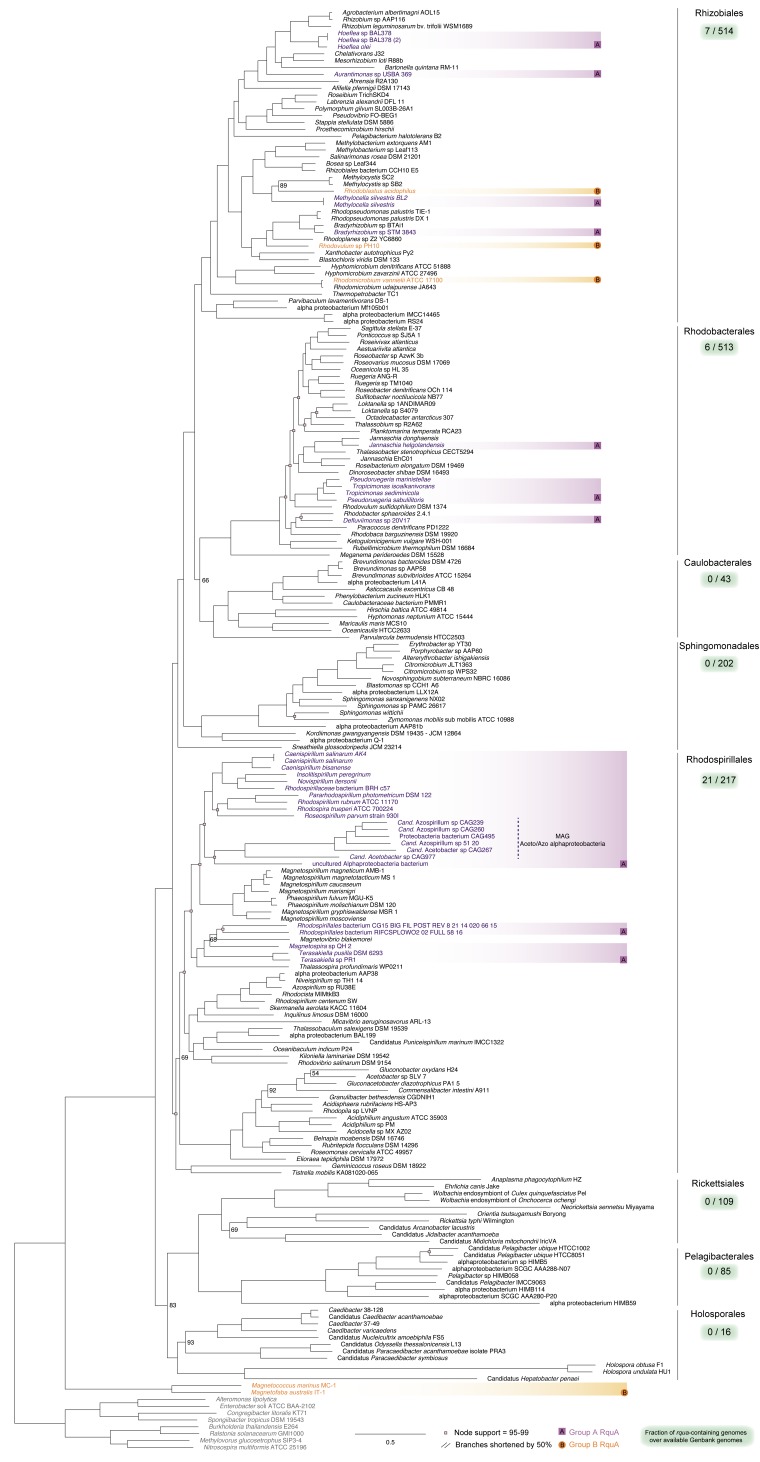
Phyletic distribution of RQUA among alphaproteobacteria superimposed on the alphaproteobacterial species tree.Maximum likelihood analysis of a 200 phylum-specific phylogenetic marker genes representing 54,400 sites from 210 representative alphaproteobacteria under the LG + C60 + F (PMSF)+ Γ4 model of evolution implemented in IQ-TREE. Tree was rooted using an outgroup of other proteobacteria. Nodes with maximal support are unlabeled, while those with support values between 95–99 are labeled with squares. RQUA-containing taxa are coloured in purple or orange representing Group A and Group B type RQUA respectively. Orders of alphaproteobacteria are indicated on the right of the tree with a summary of the number of alphaproteobacterial genomes interrogated for RQUA presence/absence in Genbank (green box).